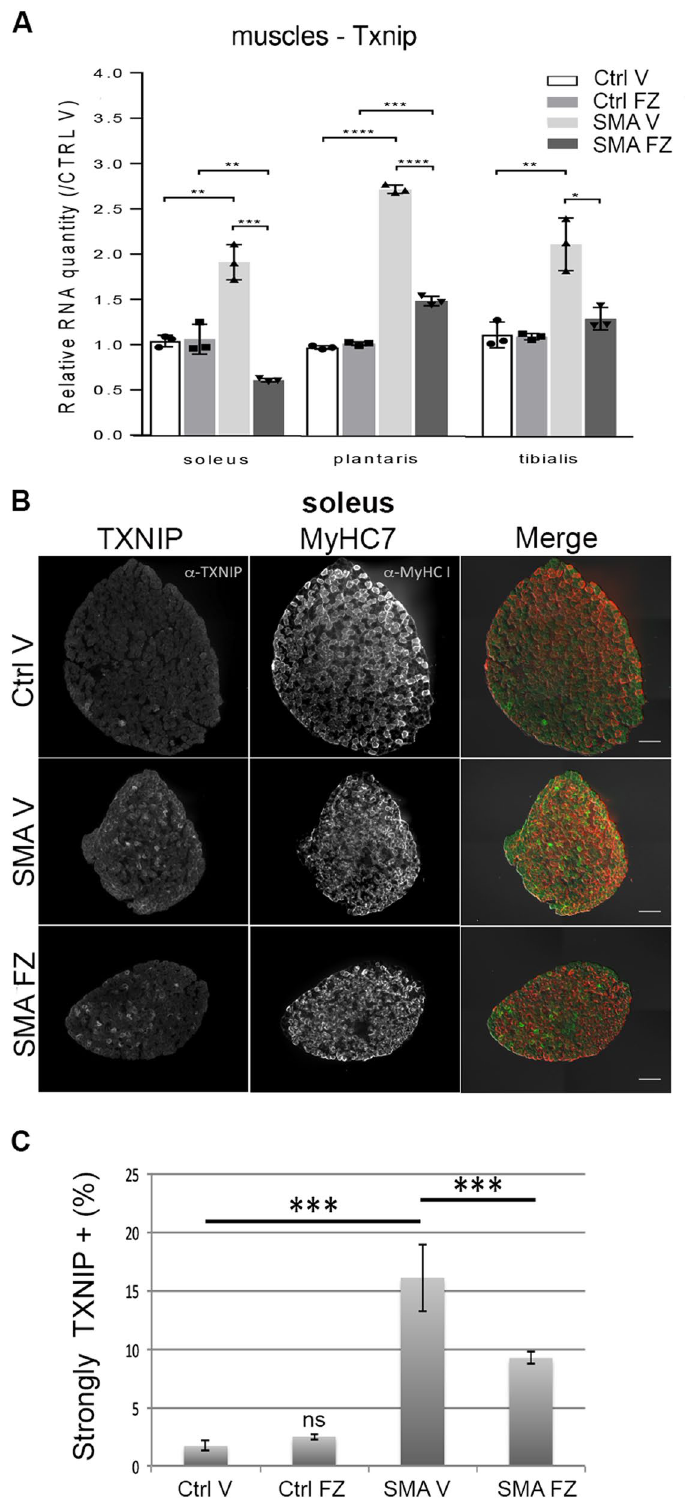
Figure 7. Flunarizine reduces the increased Txnip expression levels in skeletal muscles of SMA model mice. ( A) Txnip RNA levels in the soleus, plantaris and tibialis in vehicle- (V) and flunarizine (FZ)-treated controls (Ctrl) and SMA model mice. Vehicle-treated control (Ctrl V) is given an arbitrary value of 1. NS not significant (P > 0.05), *P < 0.05, ** < 0.01, ***P < 0.001, Student’s t test (3 mice per group). ( B) Muscle fiber immunostaining with anti-TXNIP (green) and anti-MyHC7 (red) antibodies is shown for the soleus from vehicle- and flunarizine-treated control and SMA mice at P11. ( C ) Columns represent the percentage of fibers strongly TXNIP-positive (3 mice per group). Error bars represent SD from the mean values. Scale bar, 30